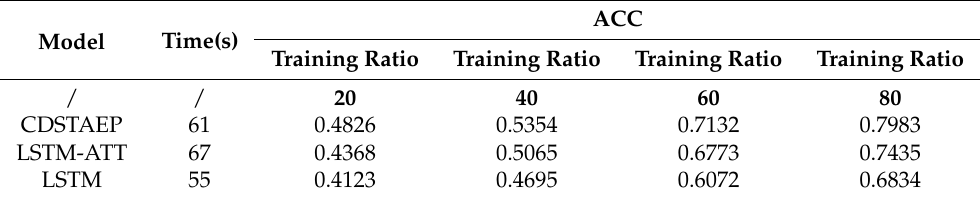
Figure 9. Comparison of prediction effects of different models: the horizontal axis is the training ratio, and the vertical axis is the ACC score. Table 8. Time efficiency and ACC for different classifiers on the dataset.